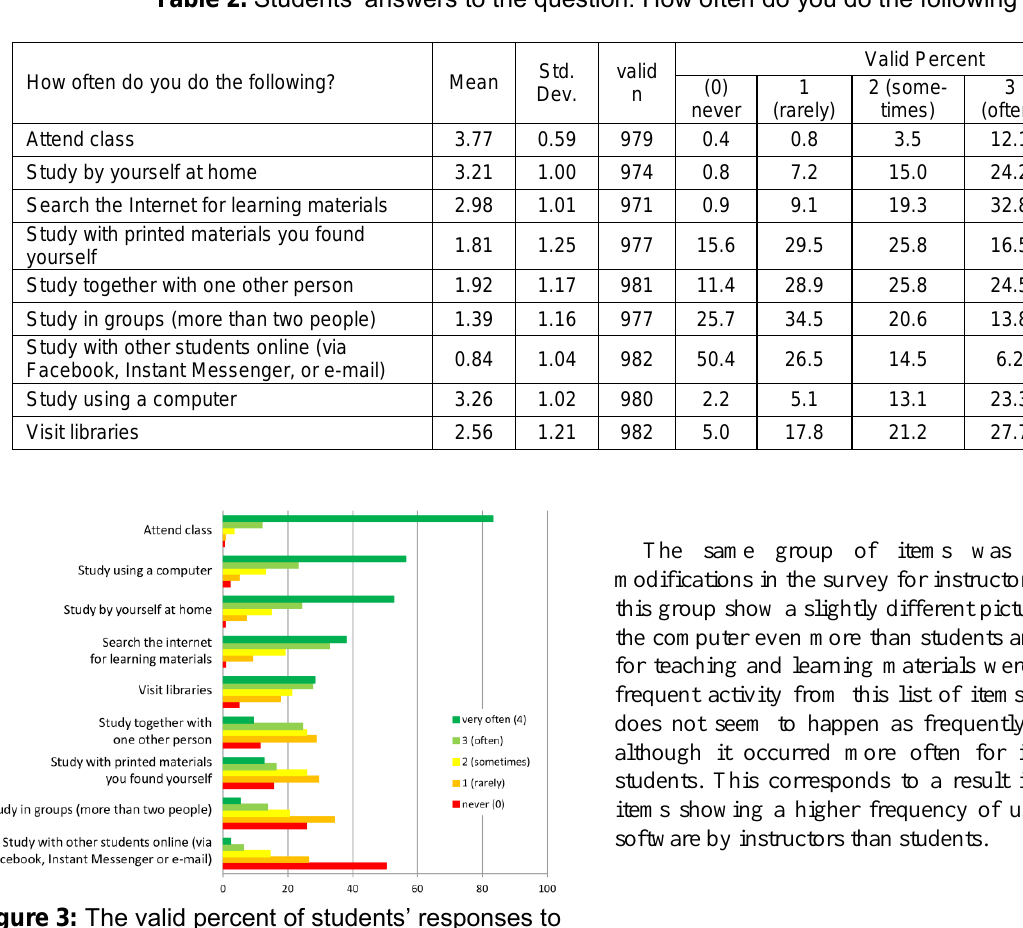
Table 2. Students’ answers to the question: How often do you do the